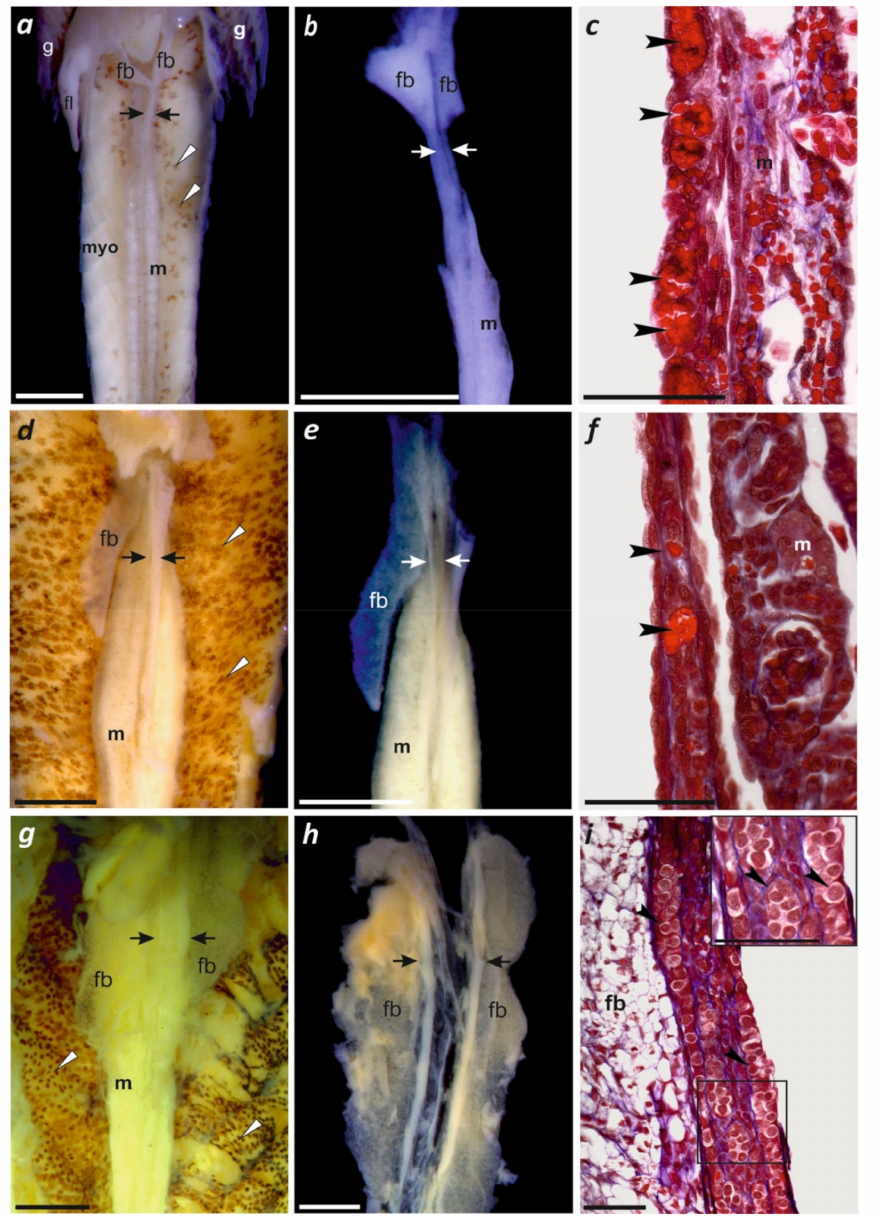
Figure 4. Developing gonads of Paradactylodon persicus (for staging: Figure 3 and Table 1). ( a – c ) Larva at day 4 after hatching; ( d – f ) at day 24 after hatching; ( g – i ) at day 41 after hatching; ( a ), ( d ) and ( g ) situs viscerum (digestive tract removed). Note the position of gonads (outlined in black: Figure S3) in relation to the mesonephroi; ( b ), ( e ) and ( h ) gonads dissected with fat bodies; ( c ) and ( f ) longitudinal section of undi ff erentiated gonads containing primordial germ cells loaded with yolk platelets (stained red); ( i ) fat body and gonocytes in early testis; inset: enlarged portion of the testis core invaded by a group of gonocytes. Abbreviations: fb : fat body ; fl : forelimb bud; g : gills; m : mesonephros; myo : trunk musculature (myomeres separated by myoseptae); white arrowheads: melanophores in the dorsal peritoneum; black arrowheads: germ cells; white or black arrows: gonads. Scale bars : a, b, d, e, g, h: 1 mm; c, f, i: 100 µ